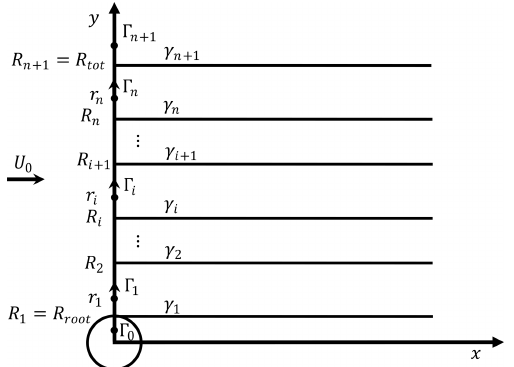
Figure 3. Sketch of the superposition of the cylindrical vortex sys- tem. The blade is extending from R root to R tot and is discretized into n sections. For section i , the radius of this calculation point is r i , and the two neighboring vortex cylinders have a radius of R i and R i + 1 and a tangential vorticity strength of γ t ,i and γ t ,i + 1 . Two ghost sec- tions with the index of 0 and n + 1 are introduced. These two ghost sections are defined to have zero bound circulation